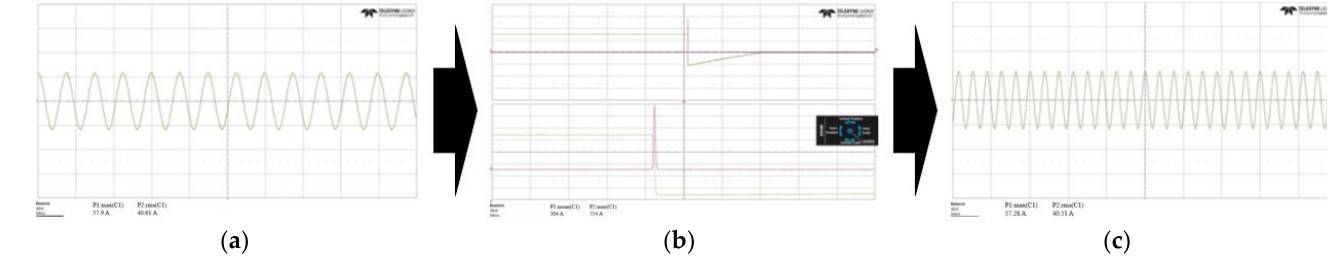
Figure 27. Waveform for conventional and proposed models; ( a ) back EMF waveform before the diamagnetic current; ( b ) diamagnetic current waveform; ( c ) back EMF waveform while applying the diamagnetic current.